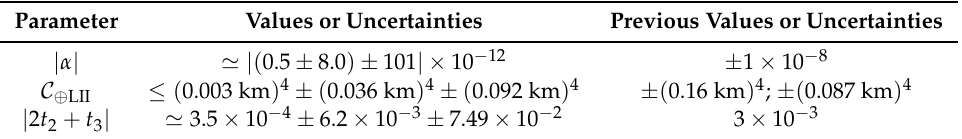
Table 9. Summary of the constraints on fundamental physics obtained in Reference [22] with their corresponding errors. The constraints are compared with previous results